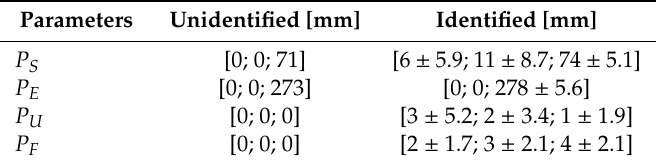
Table 2. Identified results of uncertain parameters of the exoskeleton working with Subject B.